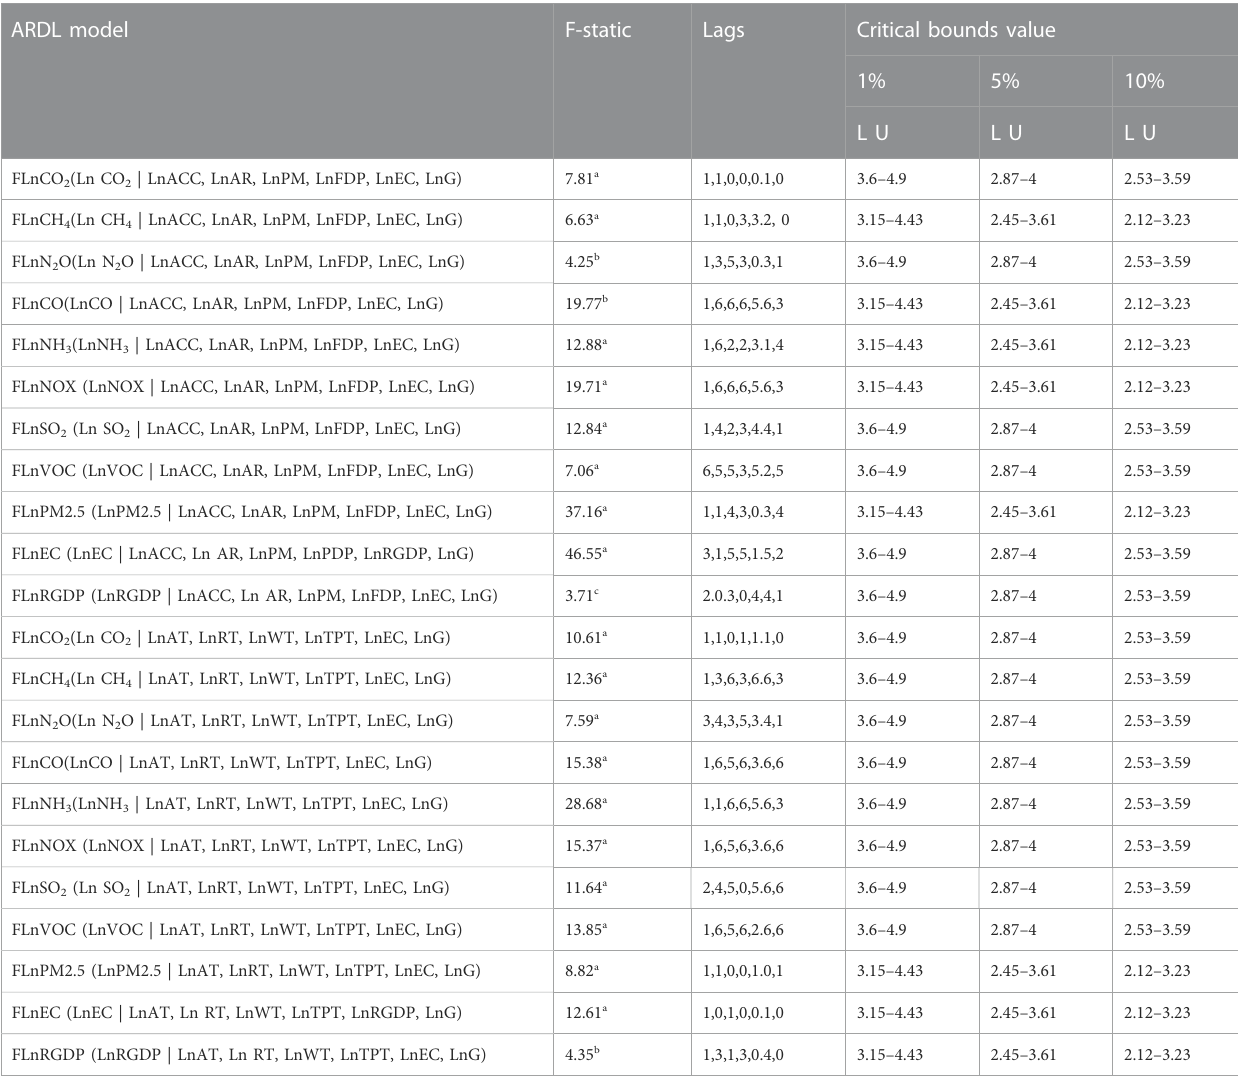
TABLE 4 The results of the bounds test for cointegration. ARDL model